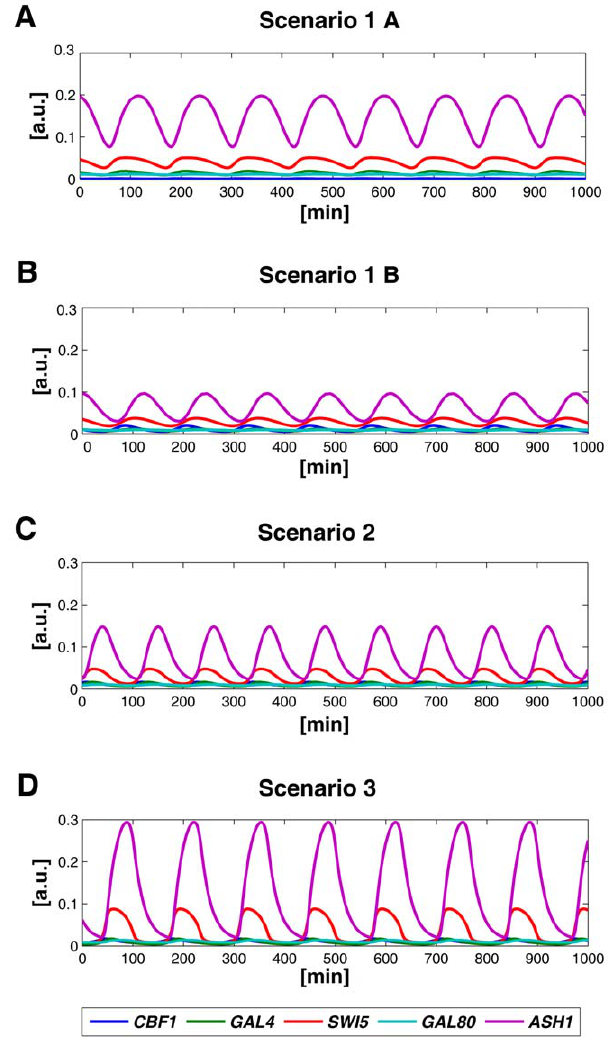
Figure 2. Turning IRMA into an oscillator: time simulations. In silico oscillations simulating the mathematical model using the parameters of Scenario 1 A, Scenario 1 B, Scenario 2 and Scenario 3. (A) Scenario 1 A, simulations of the DDEs model; parameters v 2 , k 6 , h 2 and h 6 were varied from their nominal values (Table 1, Scenario 1 A column). Period of the oscillations=120 minutes. (B) Scenario 1 B, simulations of the DDEs model; parameters k 6 , h 2 and h 6 were varied from their nominal values like in Scenario 1 A (Table 1, Scenario 1 B column), while v 2 was tuned according to the continuation results in Figure S1 E in order to increase the values of CBF1 . Period of the oscillations=120 minutes. (C) Scenario 2, simulations of the ODEs model; parameters v 2 , k 1 , k 2 , k 6 , h 3 and h 6 were varied form their nominal values (Table 1, Scenario 2 column). The negative feedback loop was removed. Period of the oscillations=110 minutes. (D) Scenario 3, simulations of the ODEs model; parameters v 2 , k 1 , k 2 , k 6 , h 3 and h 6 were varied form their nominal values (Table 1, Scenario 3 column). The negative feedback loop was removed. A positive auto-feedback loop was introduced on Swi5. Period of the oscillations=133